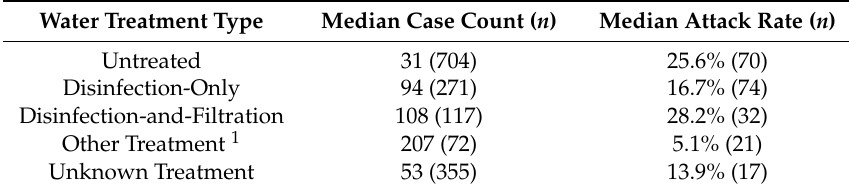
Table 8. Outbreak health data by water treatment type.